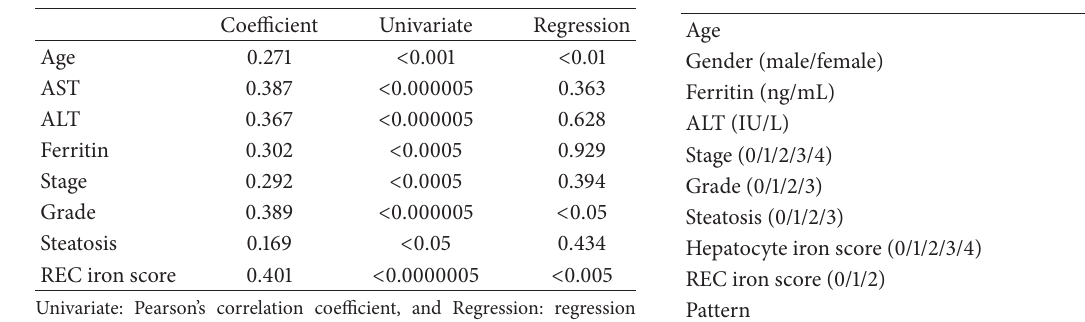
Table 4: Forty-eight patients who underwent